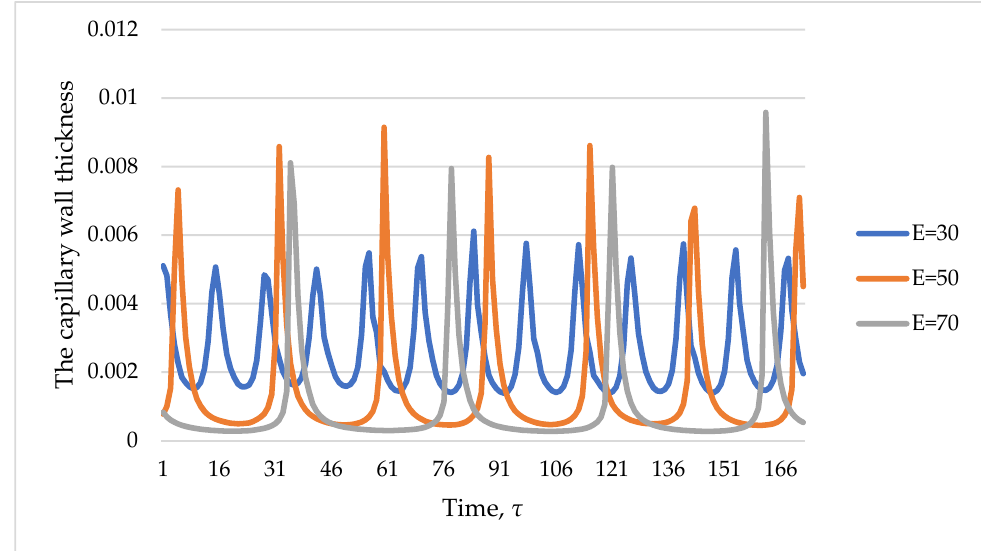
Figure 10. Time dependence of capillary wall thickness.